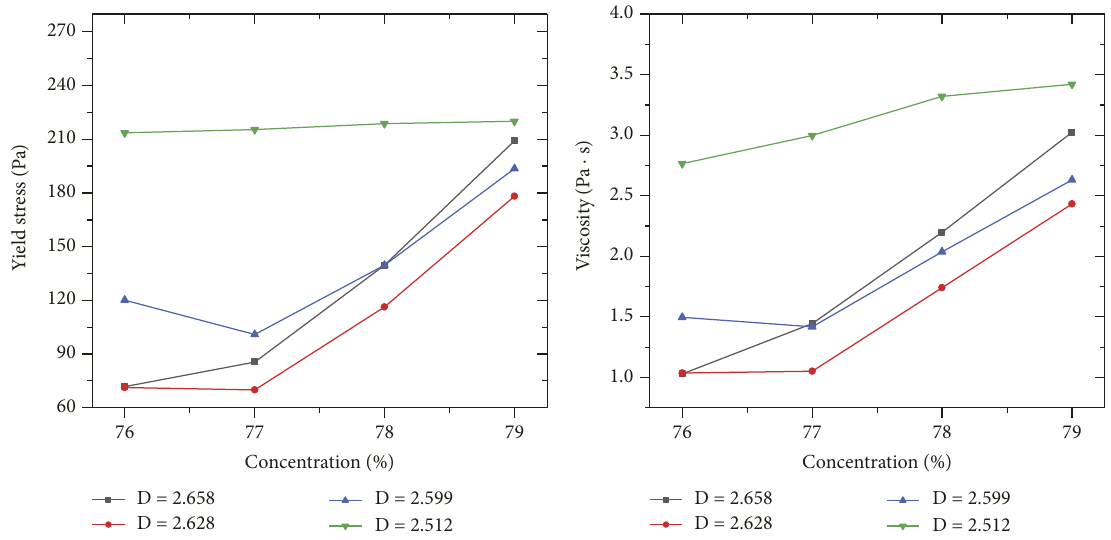
Figure 8: Effect of slurry concentration on rheological